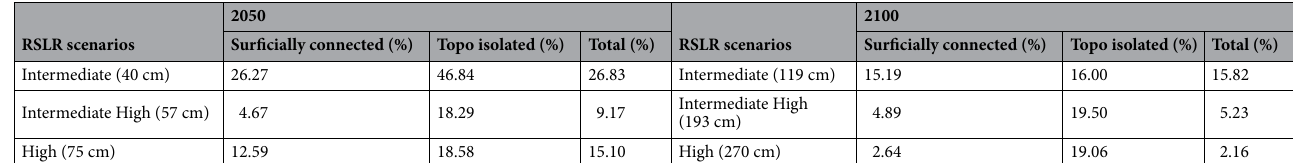
Table 1. Average across all study sites of percent difference in flood area between the ORS and TCARI approaches, for three NOAA regional sea level scenarios (Honolulu tide gauge), in the years 2050 and 2100.